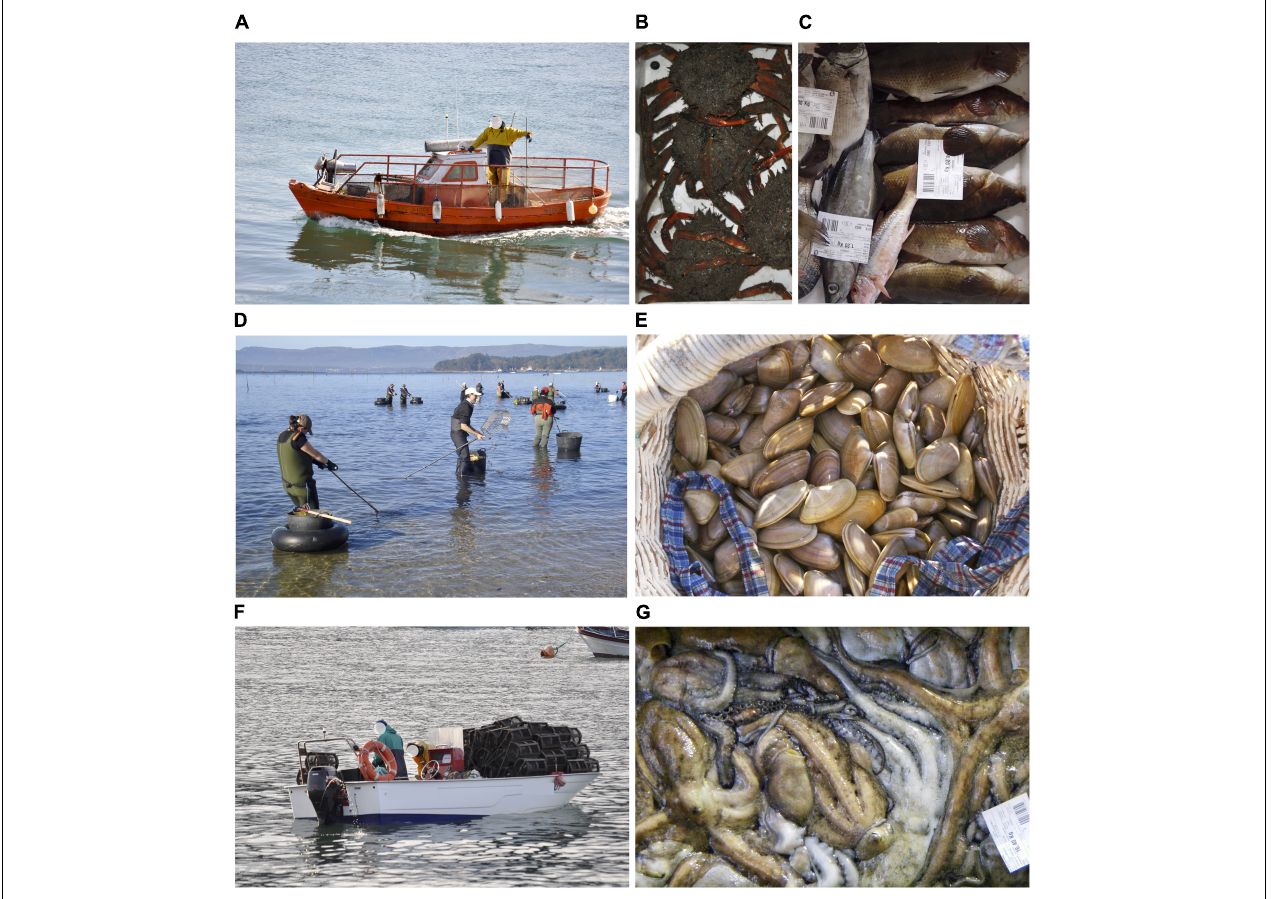
FIGURE 2 | Small-scale fishing in Galicia: (A) trammel nets ( miños ) fishing, (B,C) trammel nets ( miños ) catches (crustaceans and fish), (D) shellfishing on foot, (E) shellfishing catches (bivalves), (F) traps ( nasas ) fishing, (G) traps ( nasas ) catches (common